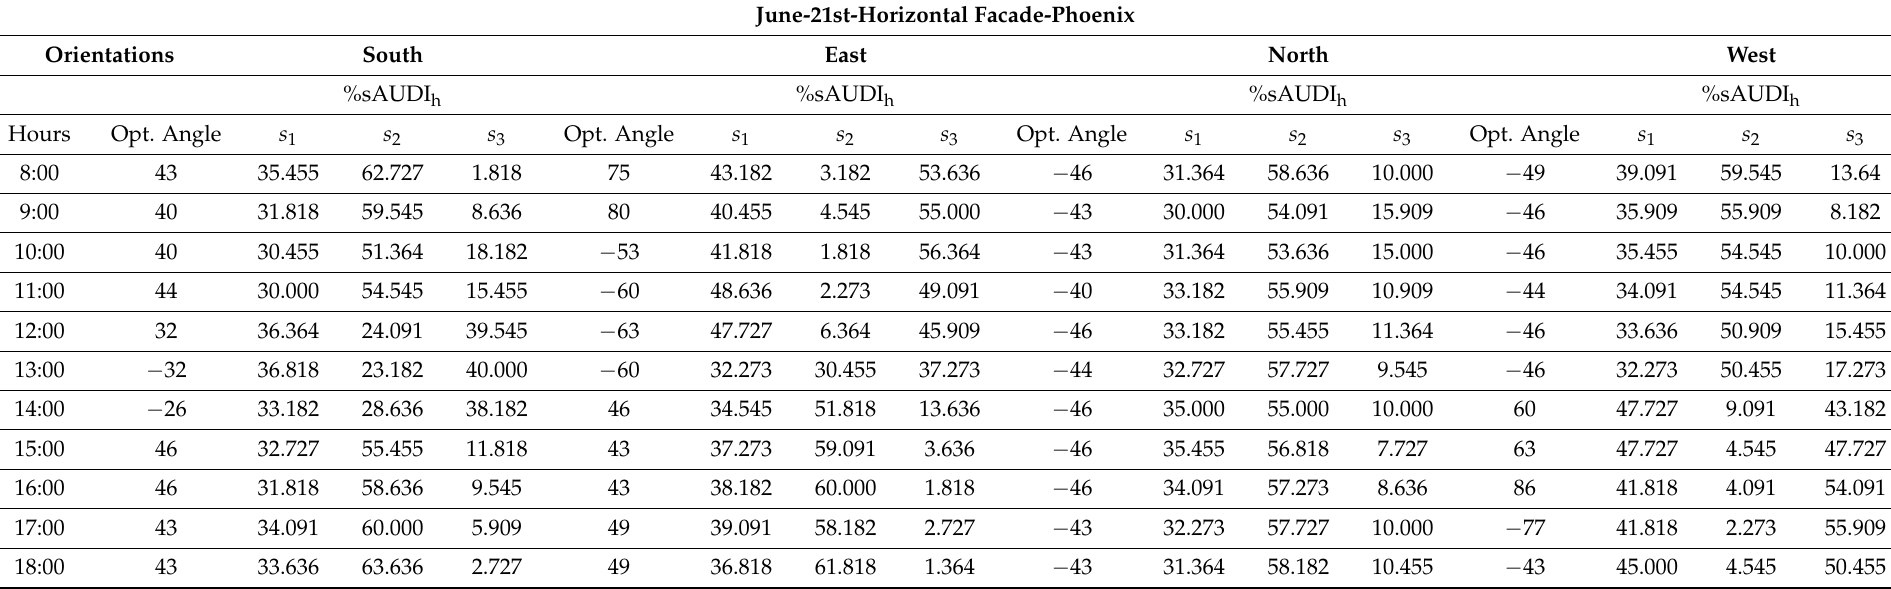
Table 2. Hourly optimum angles and the associated sAUDI h for three different human activities of s 1 , s 2 , and s 3 and four facade orientations calculated for 21 June-Phoenix-Horizontal louvers.